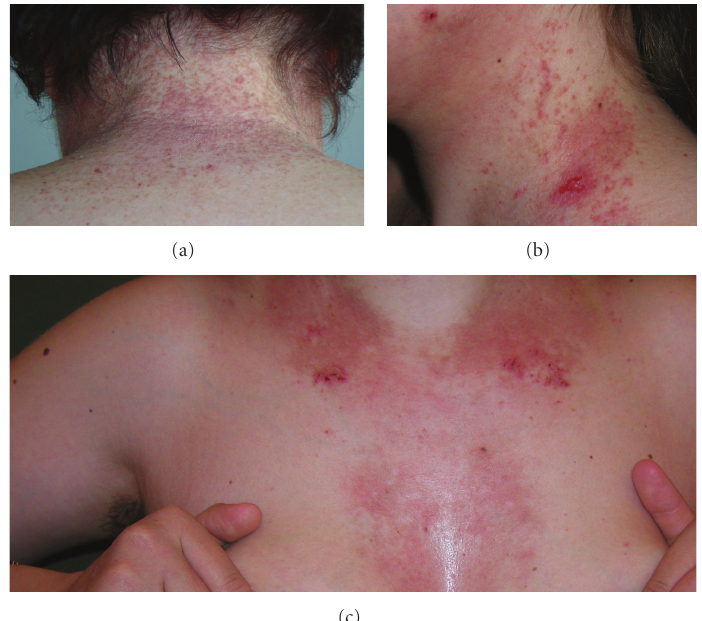
Figure 1: Clinical manifestations of the disease, with keratotic papules ((a), (b)), erythematous plaques, and crusted lesions ((b), (c)).